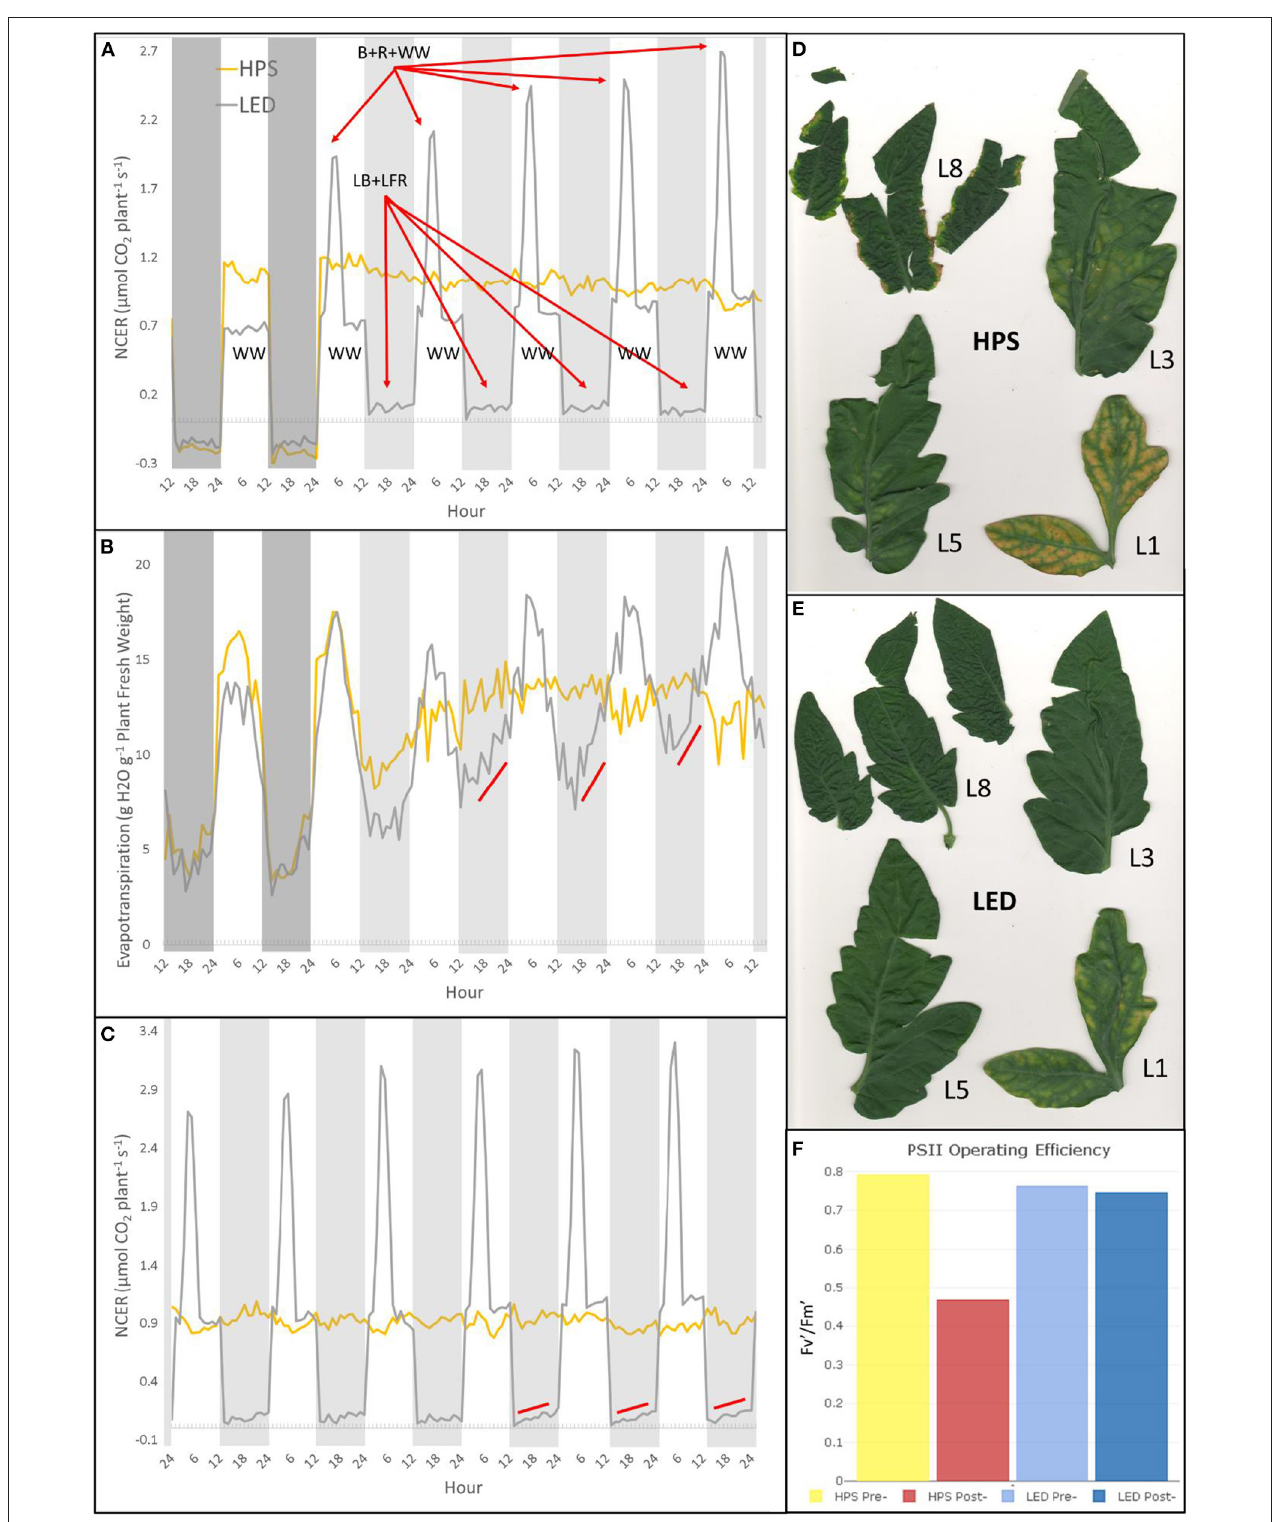
FIGURE 2 | An example of circadian rhythm entrainment using a dynamic LED recipe in a whole-plant gas exchange system. The dynamic LED recipe, which combines Lanoue et al. (2019) and Velez-Ramirez et al. (2019) treatments, grows a healthy and rhythmic 5week-old tomato “Basket Vee” plant under continuous